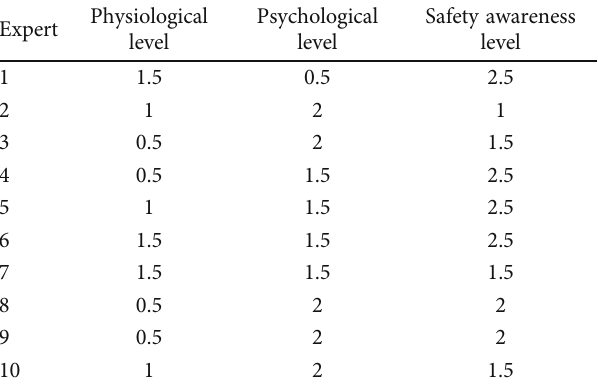
Table 3: Summary of precedence chart. Physiological Expert